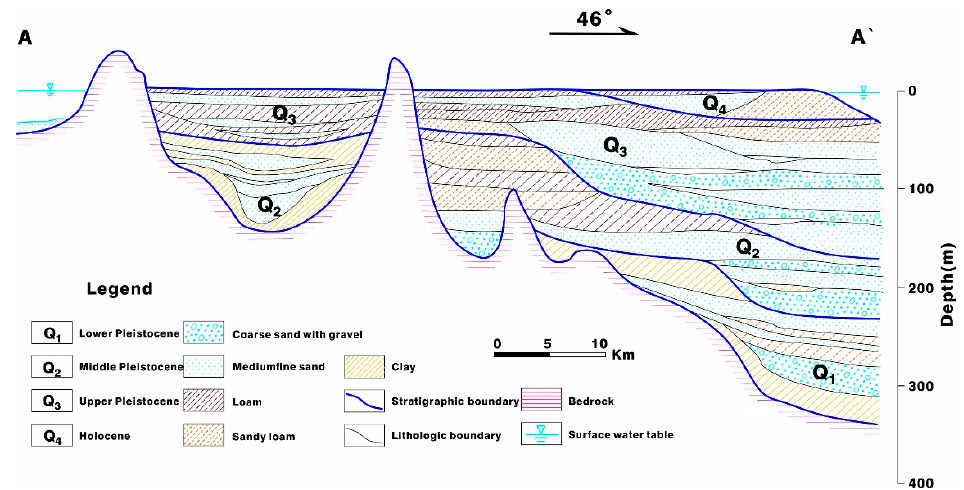
Figure 2. Hydrogeological profile of the Quaternary phreatic and confined aquifers.